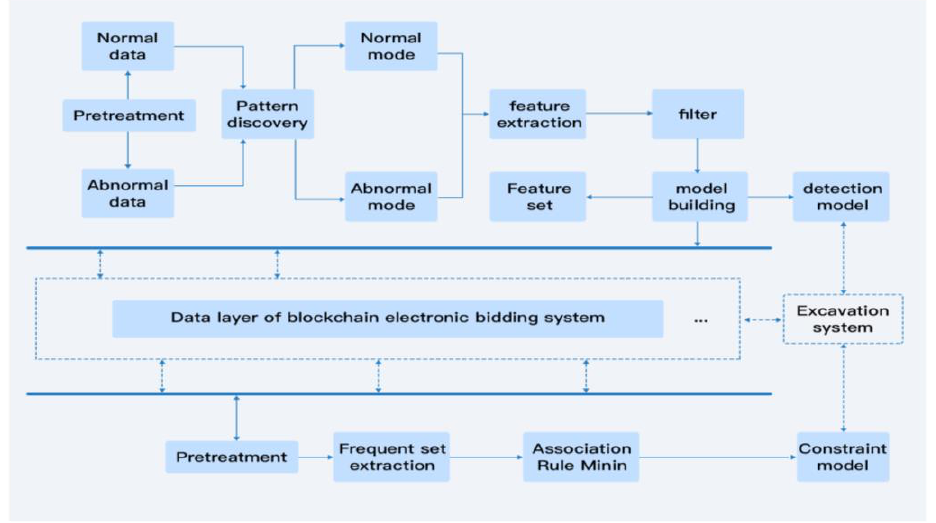
Figure 6. Evidence mining framework for bidding fraud.